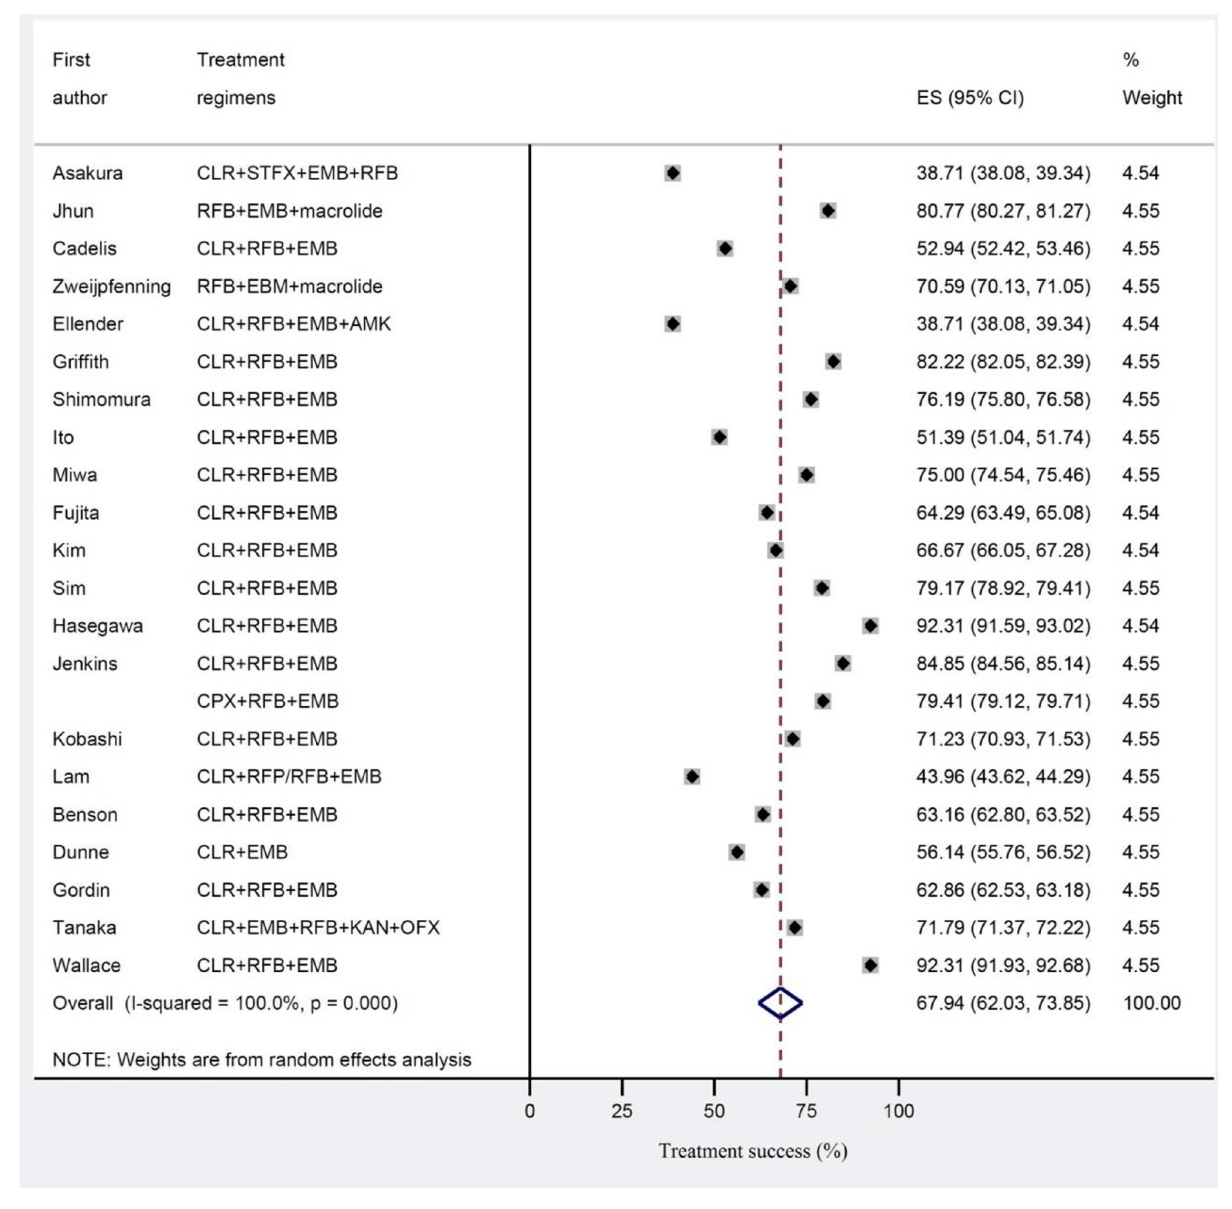
year after did not show any improvement in success